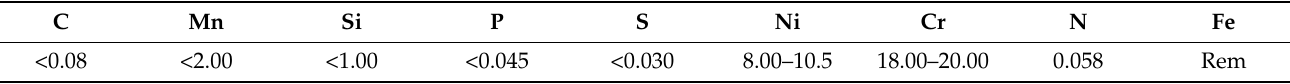
Table 1. Chemical composition of SUS 304 (wt%).